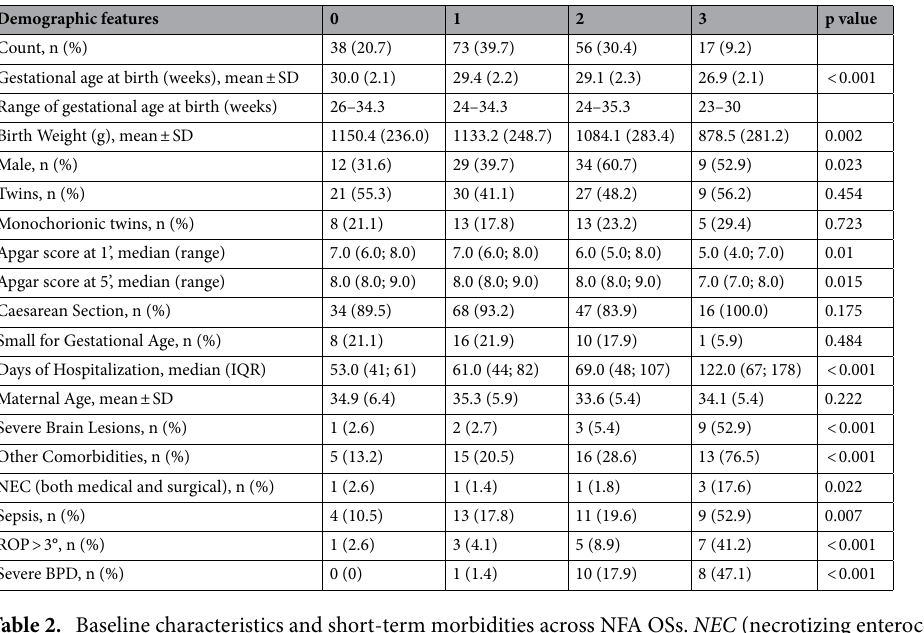
Table 2. Baseline characteristics and short-term morbidities across NFA OSs. NEC (necrotizing enterocolitis); ROP (retinopathy of prematurity); BPD (bronchopulmonary dysplasia). P values were computed using one-way ANOVA or the Kruskal ‒ Wallis test for continuous variables and Fisher’s exact test for categorical